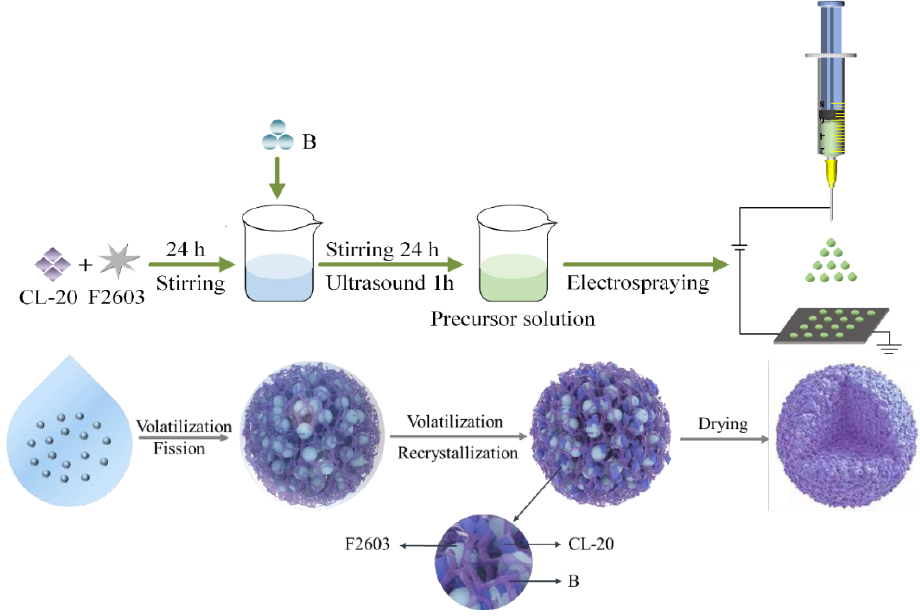
Figure 1. Schematic of electrospray process.